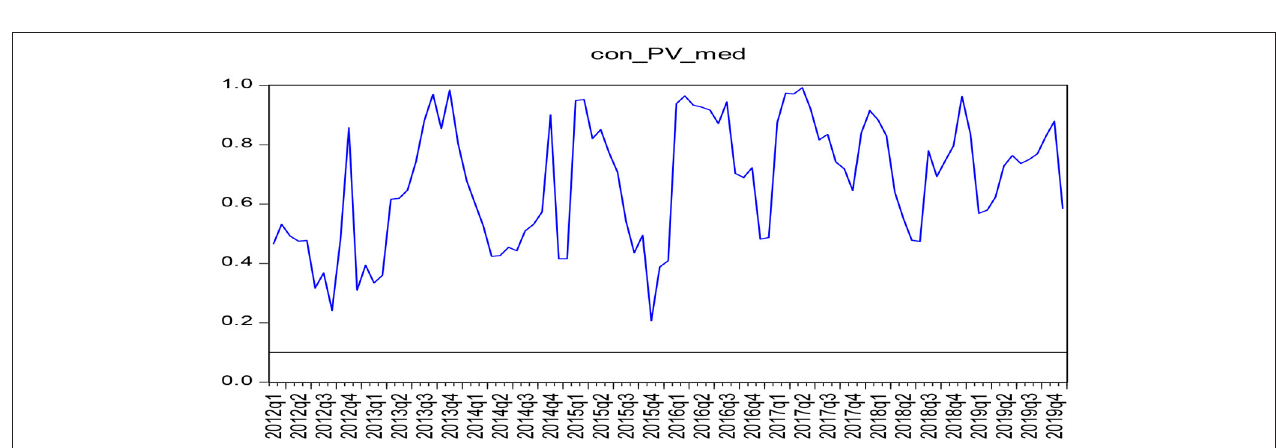
FIGURE 1 | P -value diagram of the sample test for the causality of boot-rolling (medical expenditure - consumption expenditure).